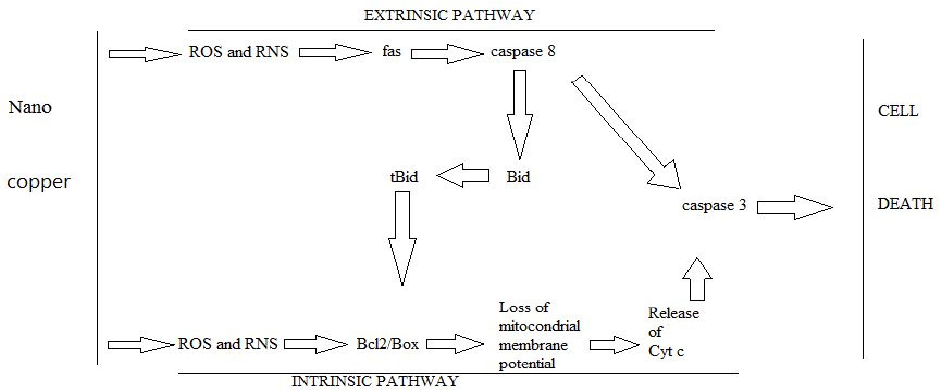
Fig. 1. Schematic diagram of the nano-copper induced apoptosis mechanism.